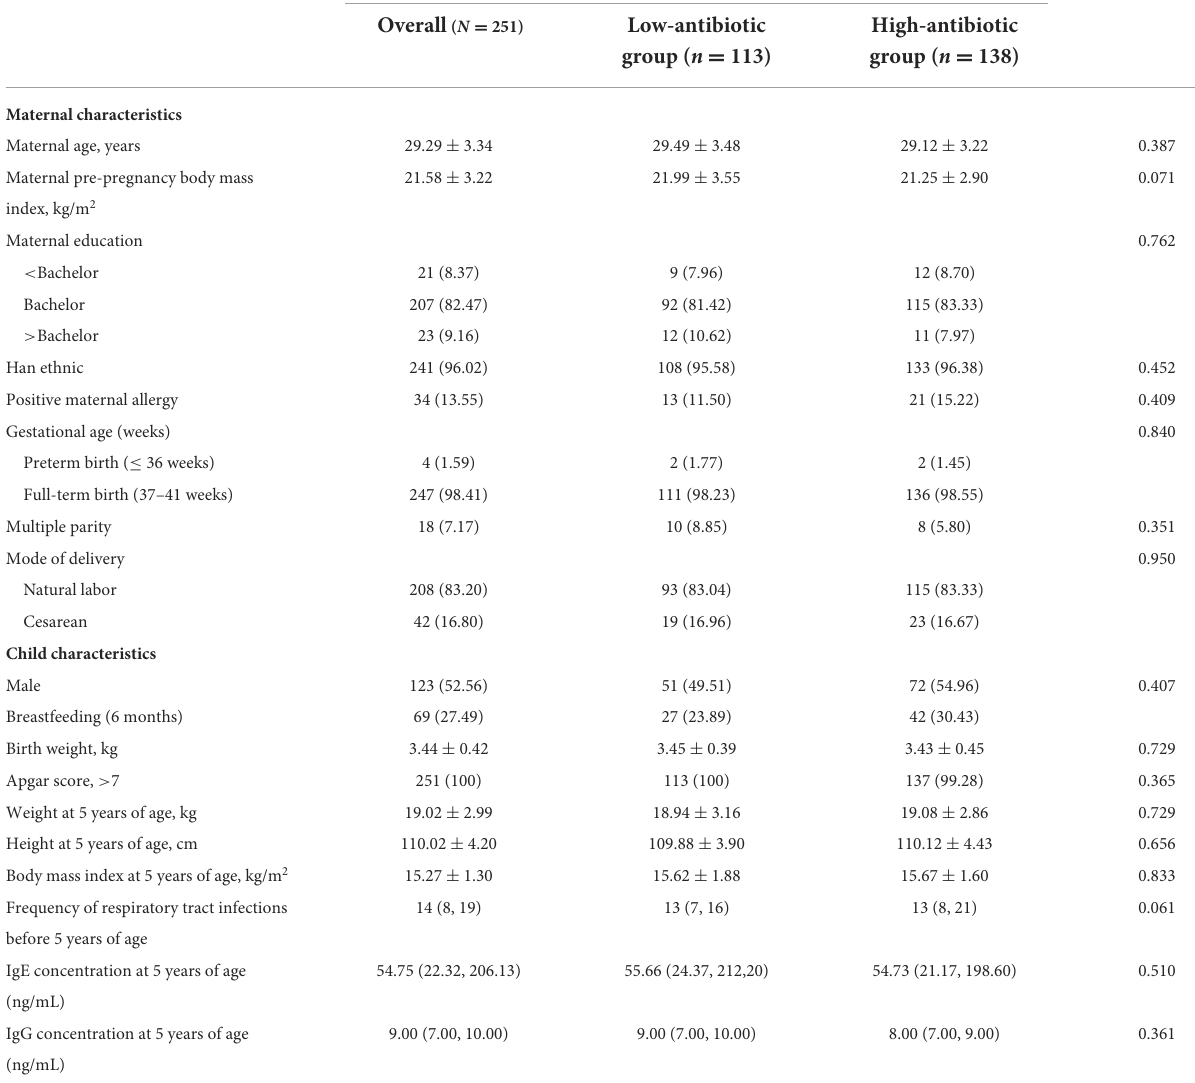
TABLE 1 Basic characteristics and children reported allergy-related outcomes of mother-infant pairs stratified by antibiotic concentration in the Shanghai Allergy Birth Cohort ( N = 251).